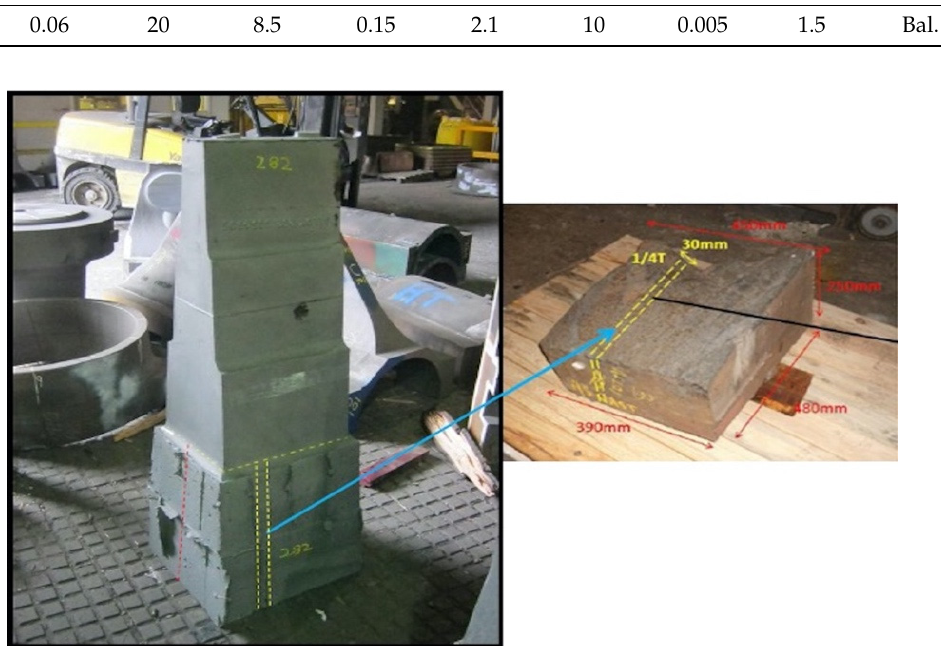
Figure 1. A plot showing the location of the materials in this study. The received specimens were cut into 1.5 cm 3 size and subjected to a range of heat treatments. One was kept in as-cast condition for comparison purpose. All other samples were undergone a two-stage solution treatment (ST), a first aging (FA) treatment and a second aging (SA) treatment, all of which are standard post heat treatments [2]. Then, the samples underwent isothermal aging (IA) at 788 ◦ C for various durations (up to 10,000 h) in order to simulate service conditions as described in Table